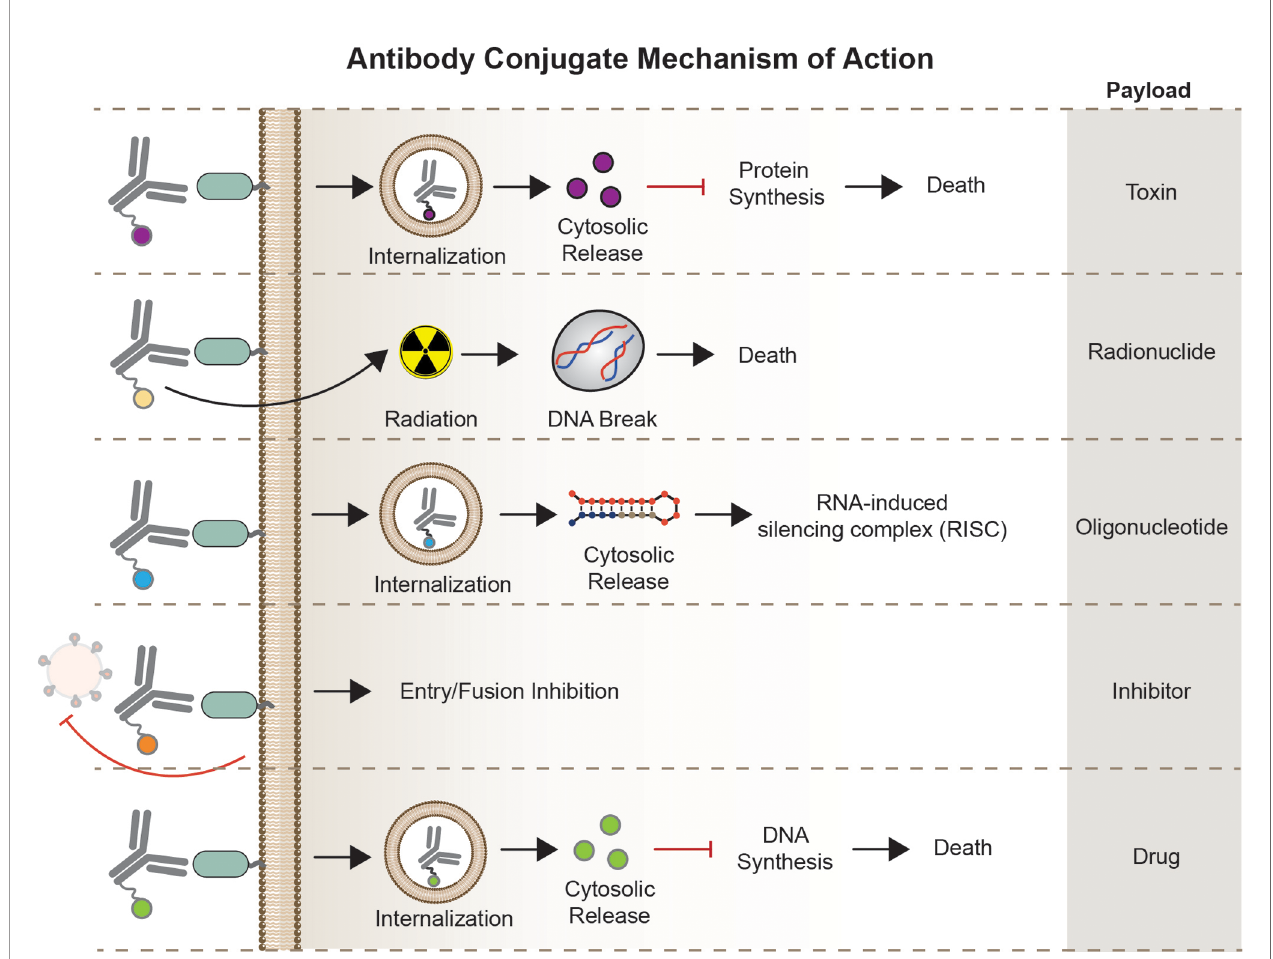
FIGURE 3 | Mechanism of Action. Antibody conjugates execute different mechanism of action depending on the carrier molecule, antigen, internalization requirement, and effector function of the payload. Antibody-toxin binds to target epitopes, internalized, followed by escape of toxin to the cytosol to halt protein synthesis. Antibody-radionuclide binds to the receptor to deliver ionizing radiation to the cell inducing DNA breaks. Antibody-oligonucleotide binds to its receptor, internalized, and bind complementary sequences in the cytosol for gene silencing. Antibody-drugs can act either internally or non-internally depending on the effector molecule – fusion inhibitor binds to a receptor or viral particle to inhibit entry, some classes of cytotoxic compounds act by intercalating to cell ’ s DNA inducing DNA/ RNA